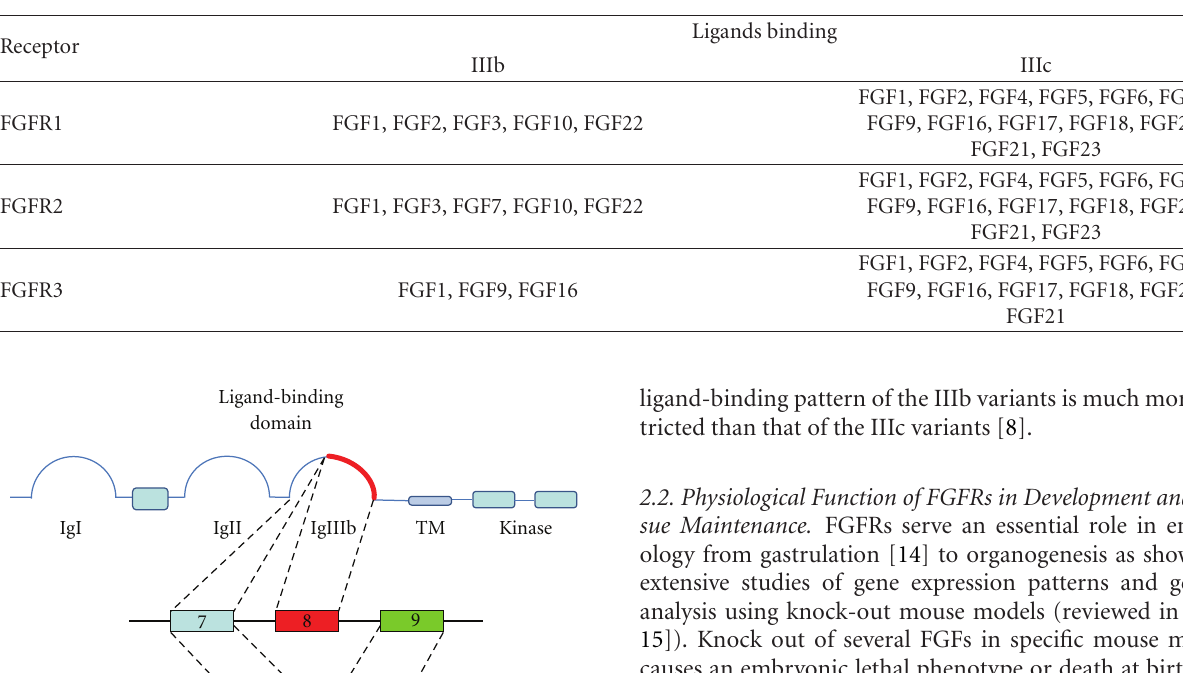
Table 1: Ligand-binding pattern of FGFR IIIb and IIIc isoforms [8].